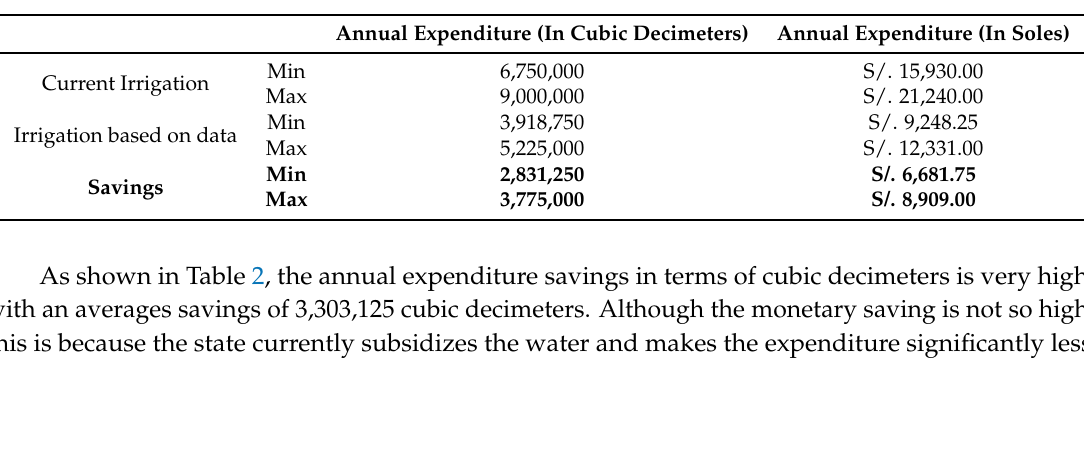
Table 2. Expenditure on